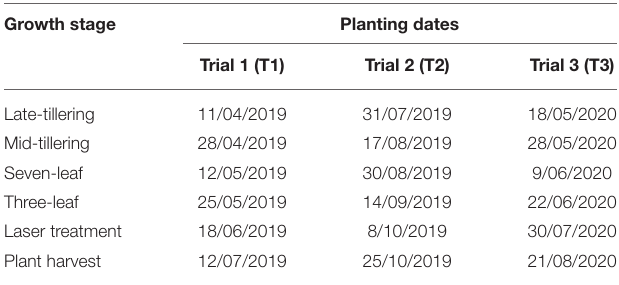
TABLE 1 | Sowing dates and treatment dates for the four growth stages across three separate trials in 2019 and 2020. Growth stage